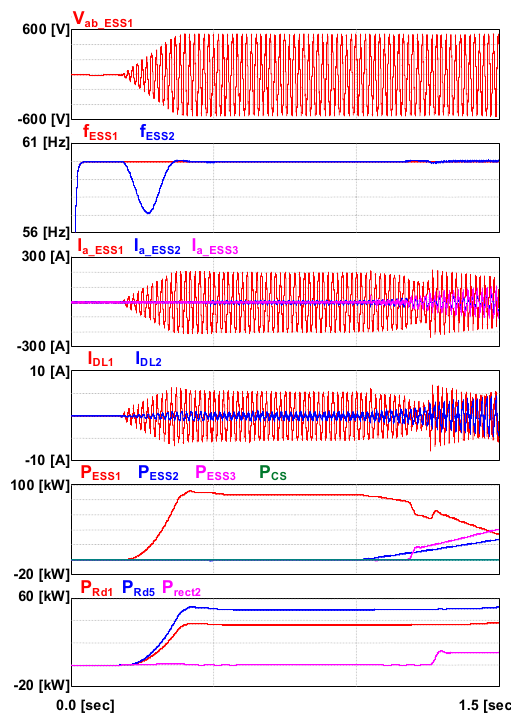
Figure 8. Simulation result—startup. The active power supplied from the three ESSs to the MG was labeled PESS1, PESS2, and PESS3, respectively, the active power supplied from the constant current source was PCS, the active power of the load that consumed the power converted into DC from the rectifier was labeled Prect1, Prect2, and Prect3, and the resistance loads that consumed the AC power were labeled PRd1, PRd2, PRd3, PRd4, and PRd5, respectively.